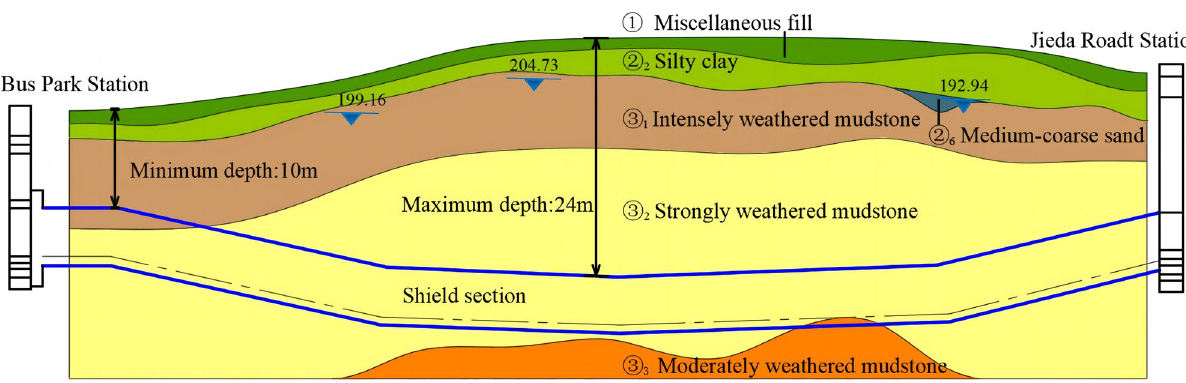
Figure 2. Schematic diagram of the geological section of the shield-bored tunnel between Bus Park Station to Jieda Road Station.